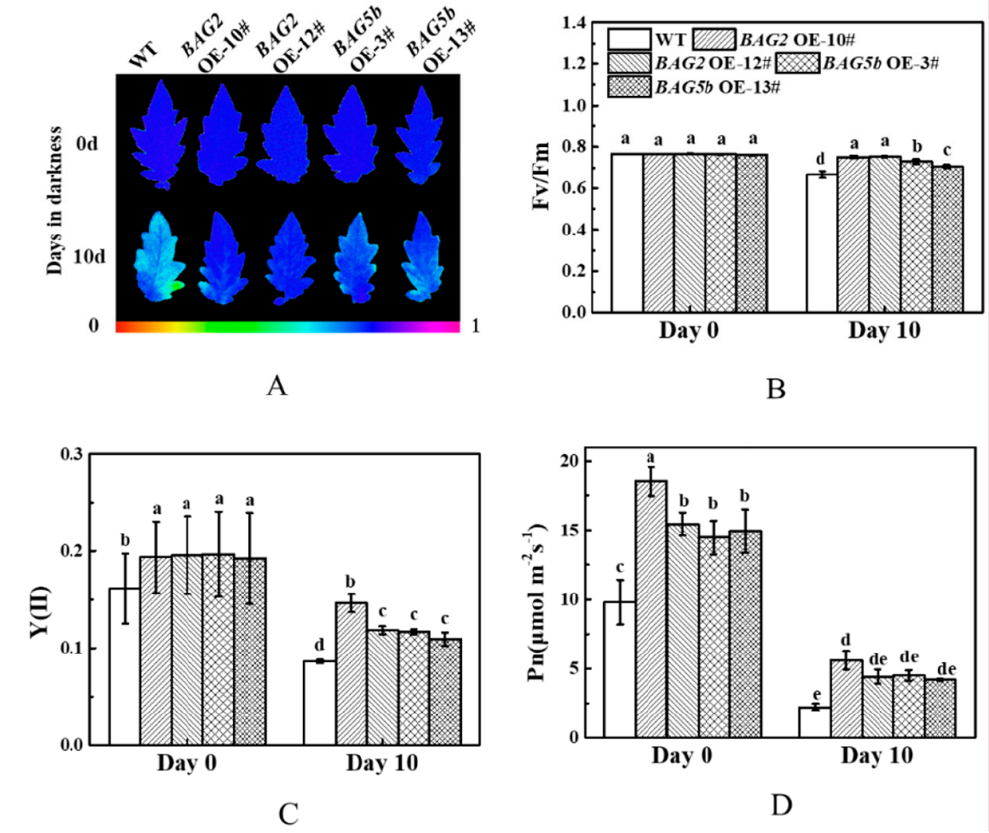
Figure 10. Effects of dark stress on fluorescence and photosynthesis of WT, BAG2 , and BAG5b overexpressing plants. ( A ): Pseudocolor images showing the maximum quantum efficiency of PSII (Fv/Fm); the color code in the images ranges from 0 (black) to 1.0 (purple). ( B ): The values of Fv/Fm in the terminal leaflets of the fourth leaves before treatment and after 10 d of darkness. ( C , D ) The values of Y(II) and Pn in the terminal leaflets of the fourth leaves before treatment and after 10 d of darkness. Different letters indicate significant differences at P < 0.05. 10# and 12# represent 2 lines of BAG2 OE plants; 3# and 13# represent 2 lines of BAG5b OE plants; OE, overexpression; WT, wild